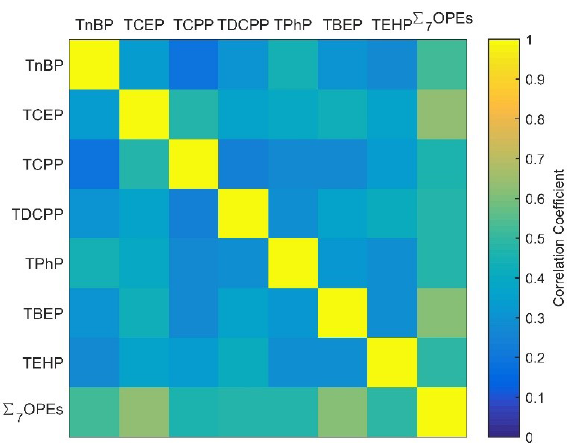
Figure 5. Spearman’s rank correlation coefficients between the con- centrations of individual OPEs in PM 2 . 5